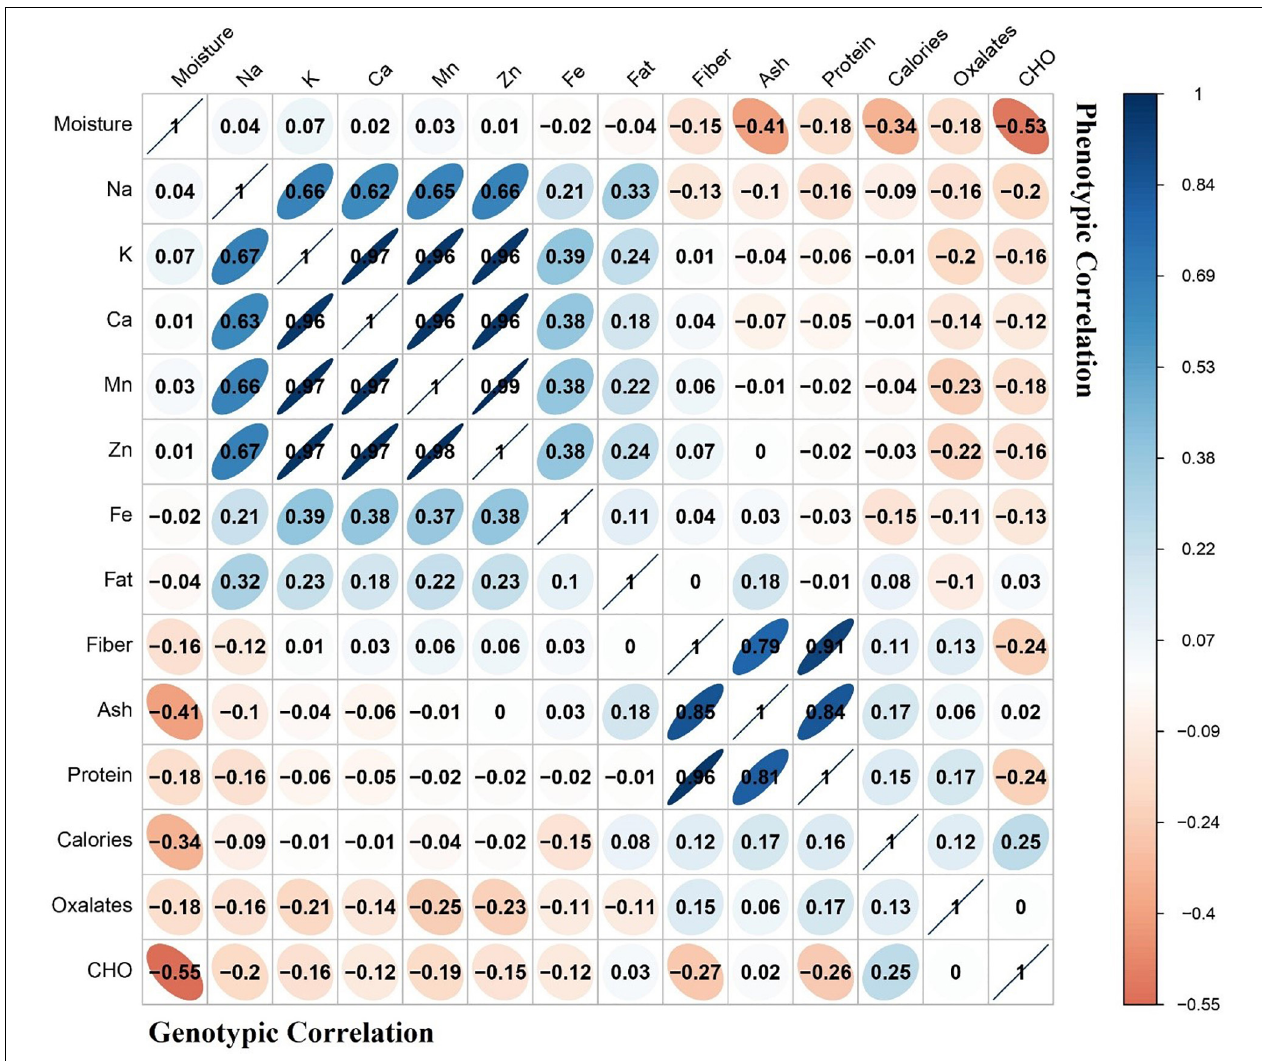
FIGURE 1 | Heat map indicating phenotypic and genotypic correlations of nutritional contents. Dark blue color is the representation of greater correlation level.